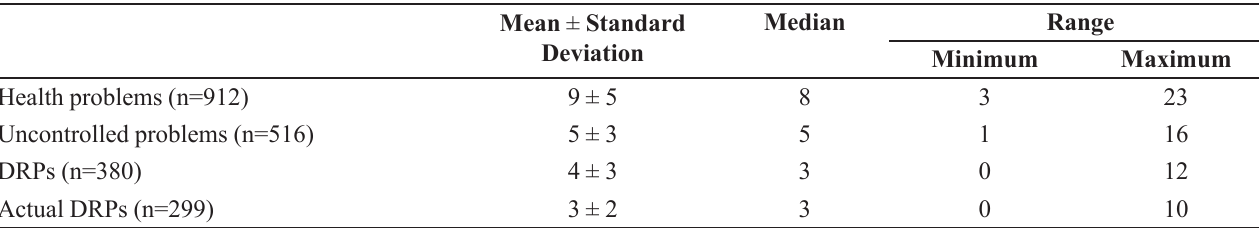
TABLE III – Descriptive analysis of problems observed at FECUNP, 2001 to